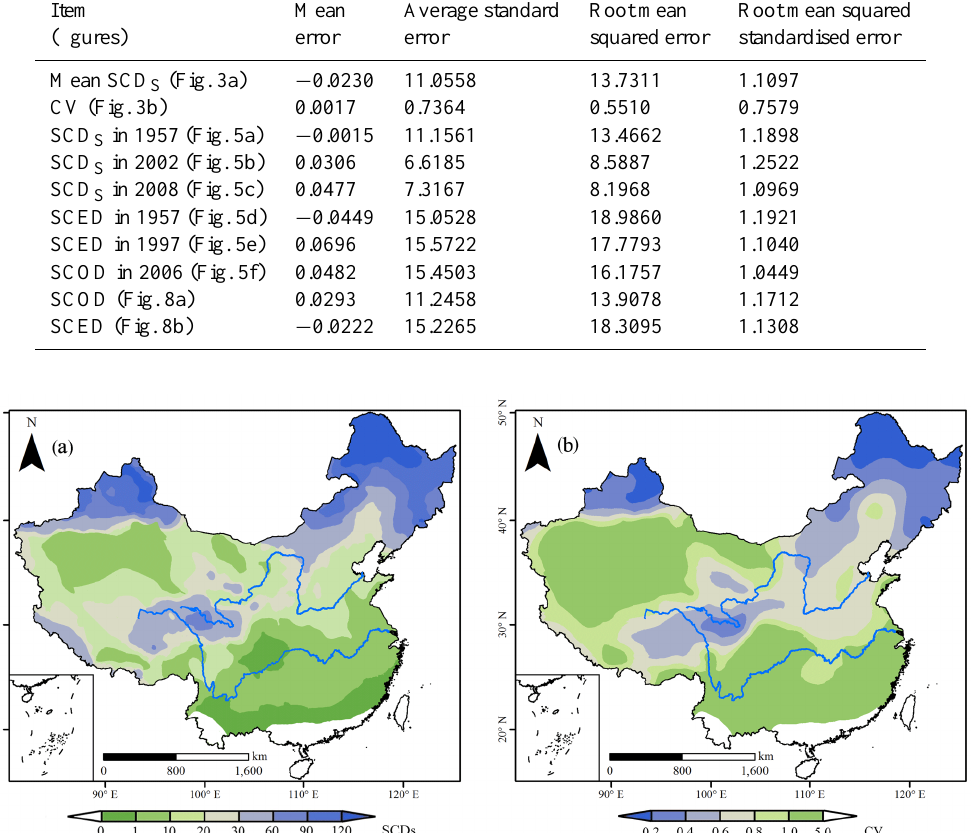
Figure 3. Annual mean snow cover days (SCDs) from 1980/1981 to 2009/2010 (a) , and their coefficients of variation (CVs) (b)